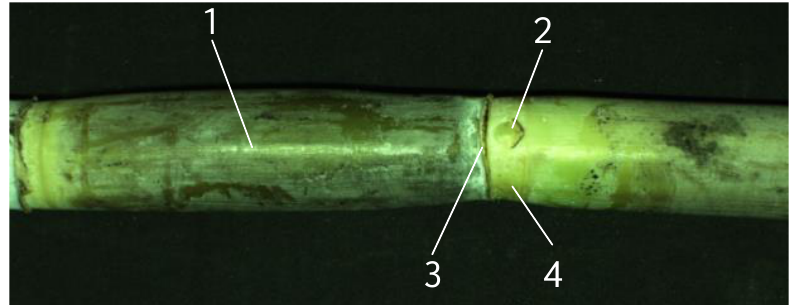
Figure 1. Sugarcane stem. (1) Internode, (2) cane bud, (3) leaf mark, and (4) stem node.